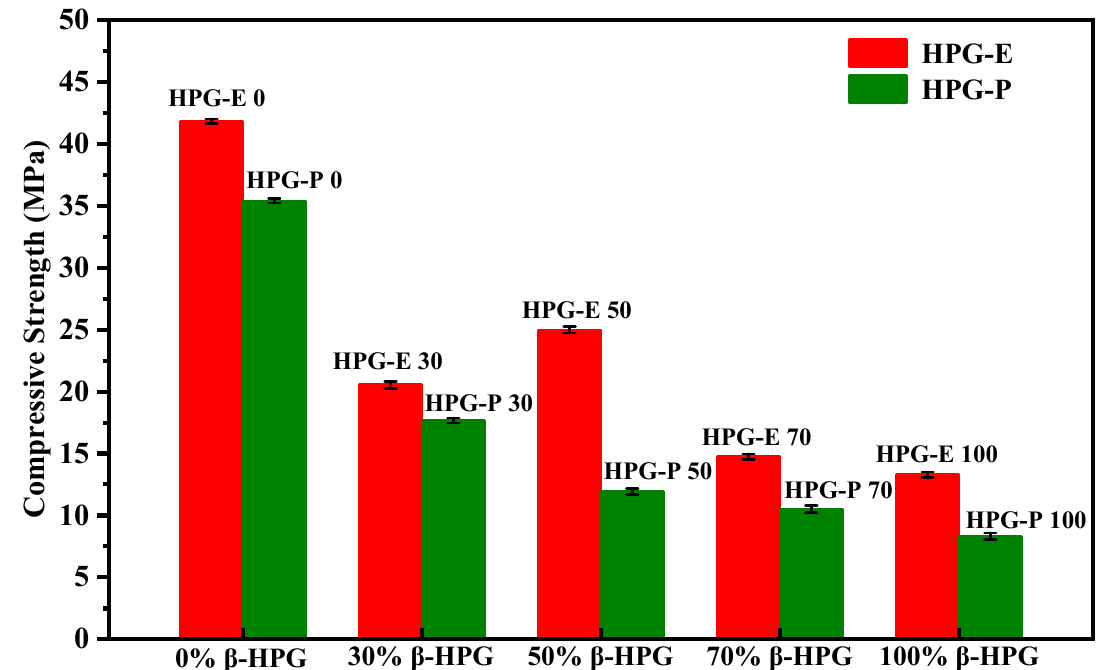
Figure 1. Compressive strength of HPG-P composites and HPG-E composites.